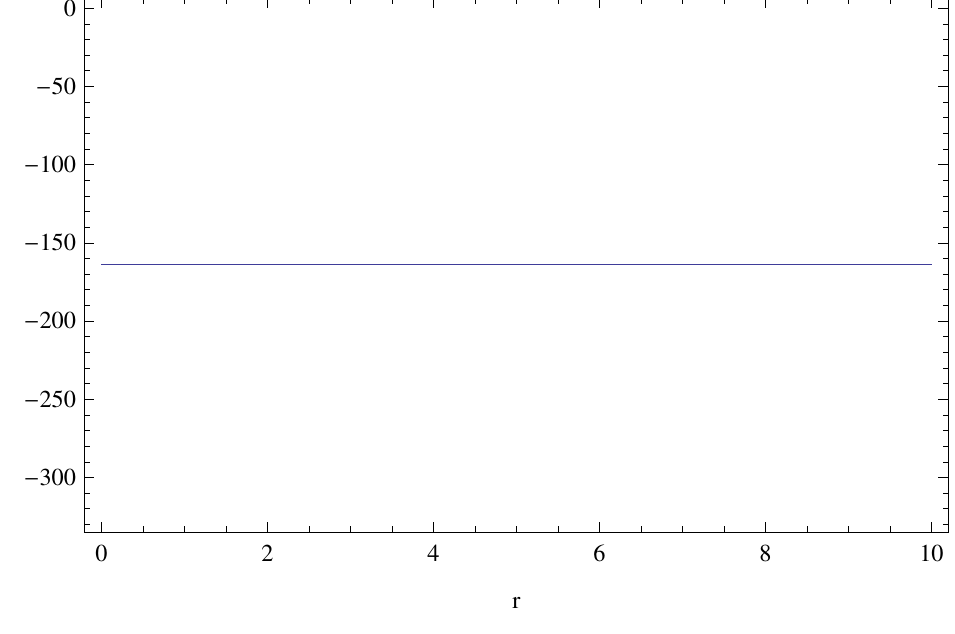
Figure 5. The Ricci scalar is plotted against the radial parameter r , for dark energy matter ( ω = − 1), for the values of constants λ = − 0.1, C 1 = 0.01, C 2 = 0.5, C 3 =